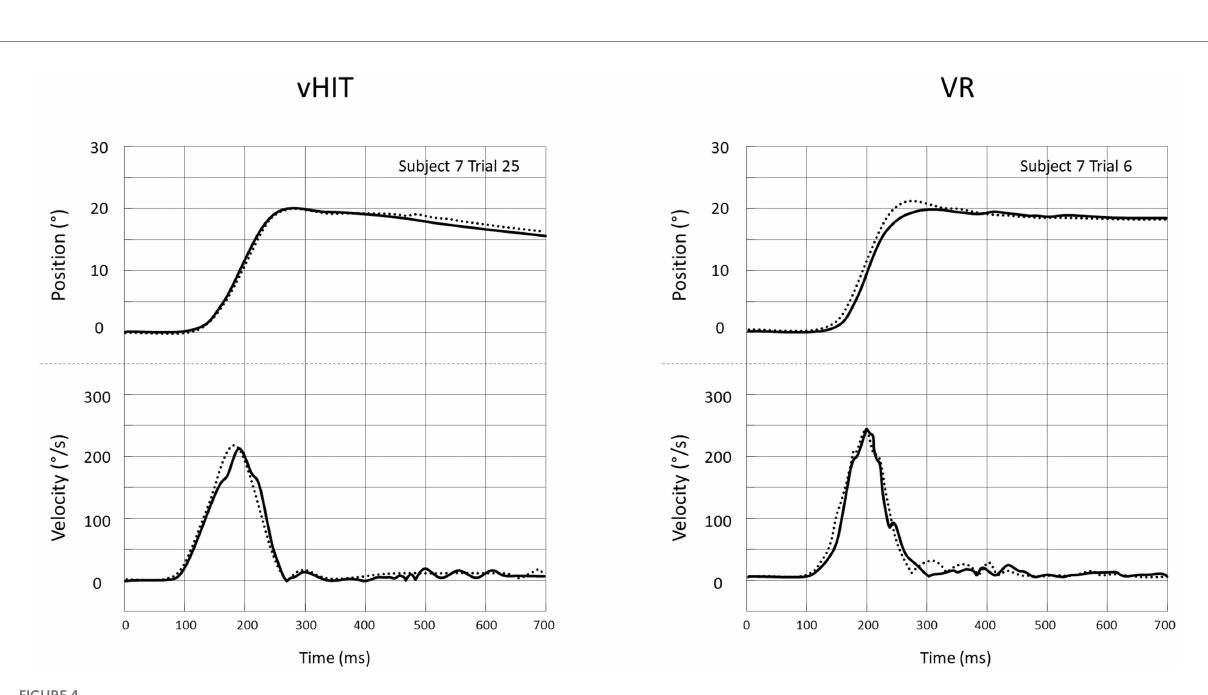
FIGURE 4 Head ( ……. ) and eye ( ___ ) positions (top) and absolute velocities (bottom) for single head impulses recorded in the vHIT setting (left) and the VR-HIT setting (right) . Eye positions are inverted in the plot by convention. In both cases, recordings are from the same person and the same direction of